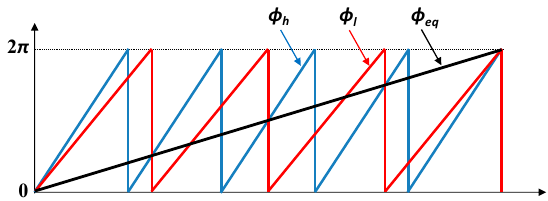
Figure 3. The illustration of equivalent phase map φ eq calculation as the difference between φ l and φ h in the multi-wavelength temporal phase unwrapping approach. φ eq is also regarded as the reference phase with the phase value ranges from 0 to 2 π .